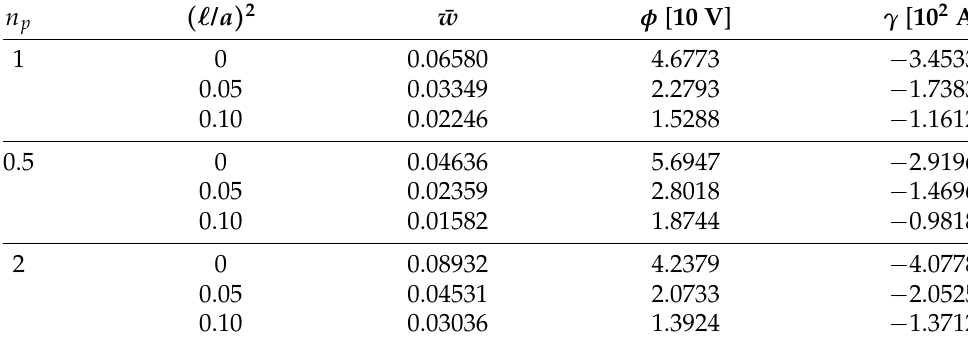
Table 5. Displacement ¯ w , electric and magnetic potential φ and γ , of a square nanoplate in central point ( a /2, b /2 ) for different values of nonlocal parameter ( (cid:96) / a ) 2 and n p . (SDL; q = 0 N/m 2